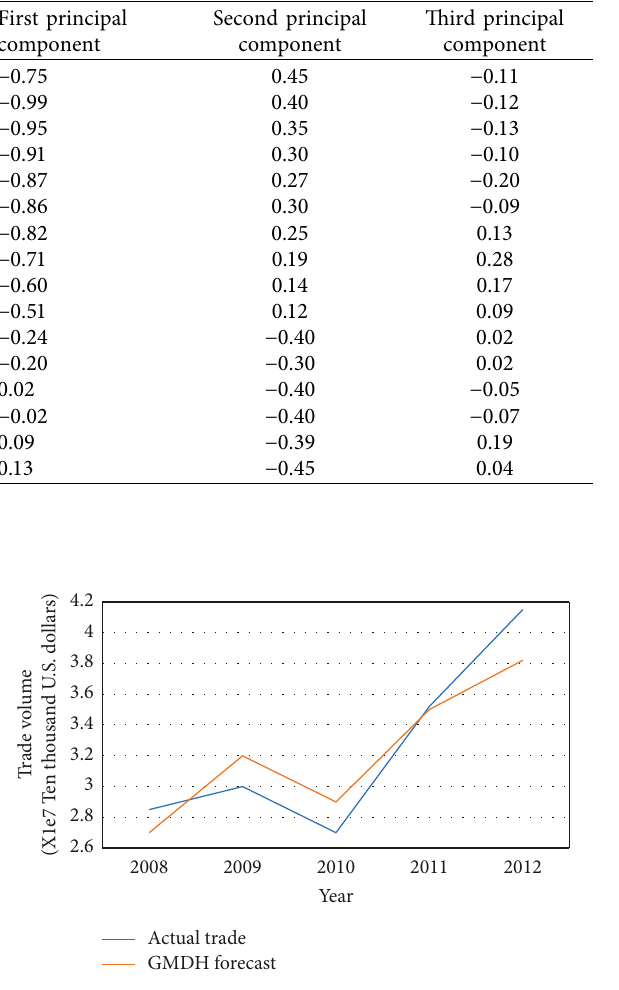
Figure 4: Growth rate of China’s import and export trade in 2020. Table 3: Principal component data.